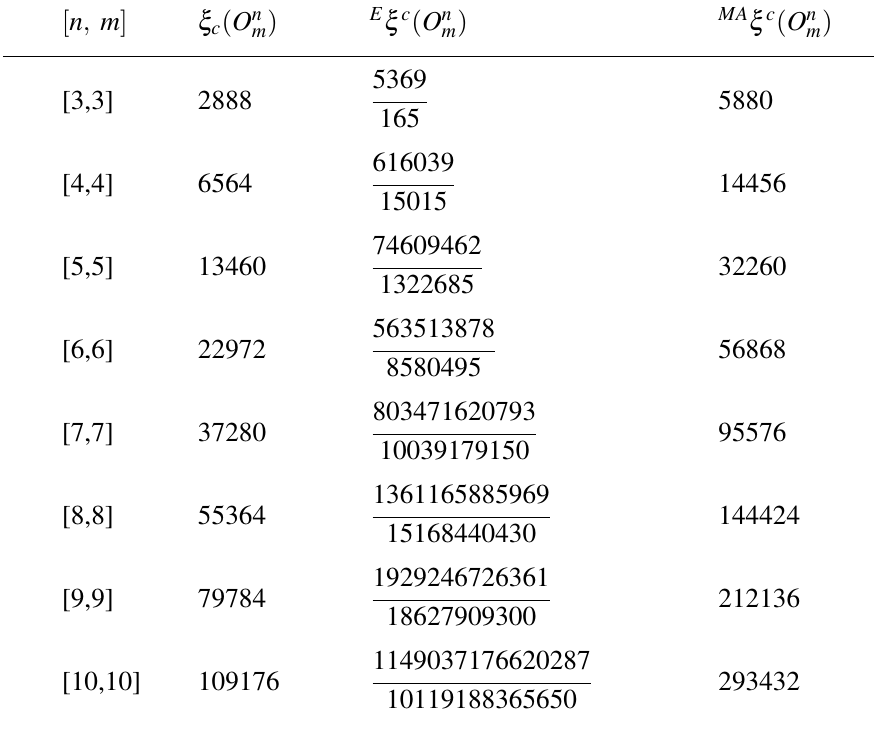
) , E ξ c ( O n ) and MA ξ c ( O n m m